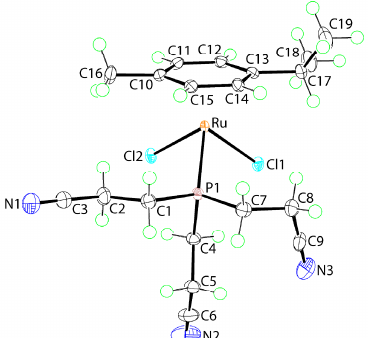
Figure 1. The molecular structure of 1 showing atom labelling and displacement ellipsoids at the 70% probability level. Selected geometric parameters: Ru–Cl1 = 2.4226(4), Ru–Cl2 = 2.4094(4), Ru–P1 = 2.3481(5), Ru–C15 = 2.1831(18), Ru–C13 = 2.2374(18) Å, Cl1–Ru–Cl2 = 89.990(15), Cl1–Ru–P1